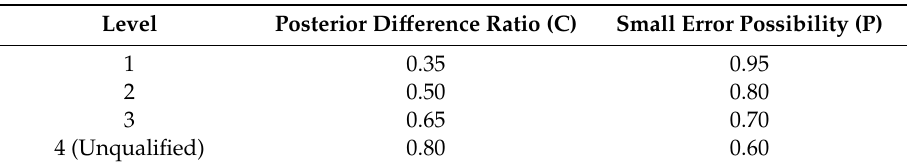
Table 2. Levels of prediction